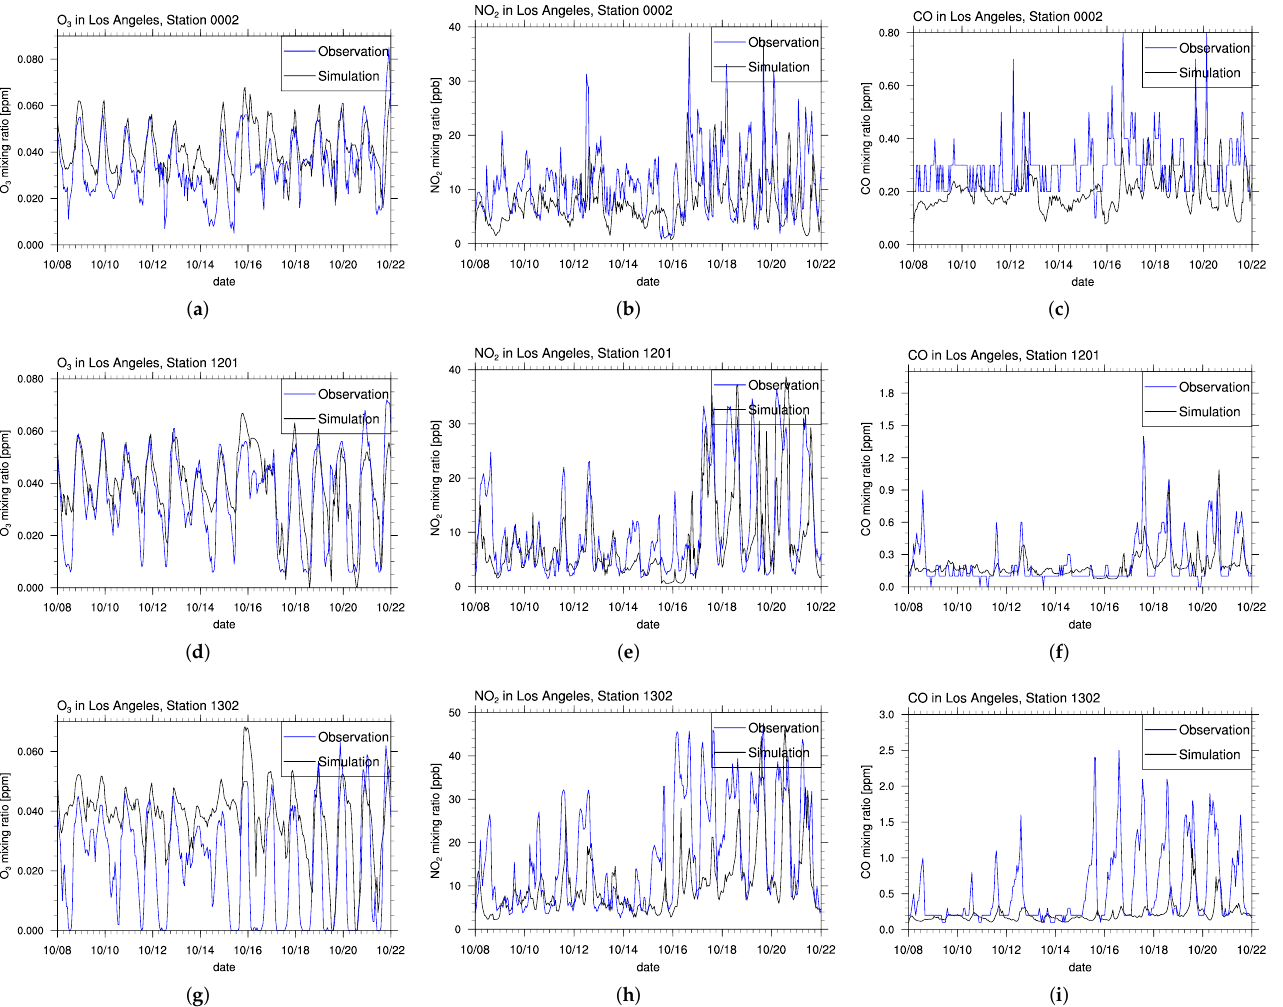
Figure 10. Comparison of in situ measurements with modeled ozone, NO 2 , and CO at the ground at Los Angeles, i.e., Azusa ( a – c ), Reseda ( d – f ), and Compton ( g – i ) in October